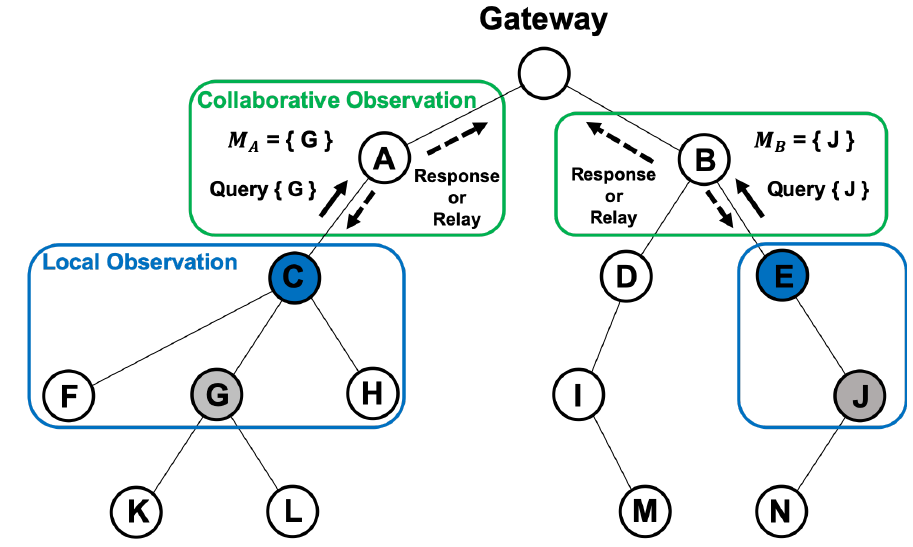
Figure 4. Example of the observation phase consisting of 2